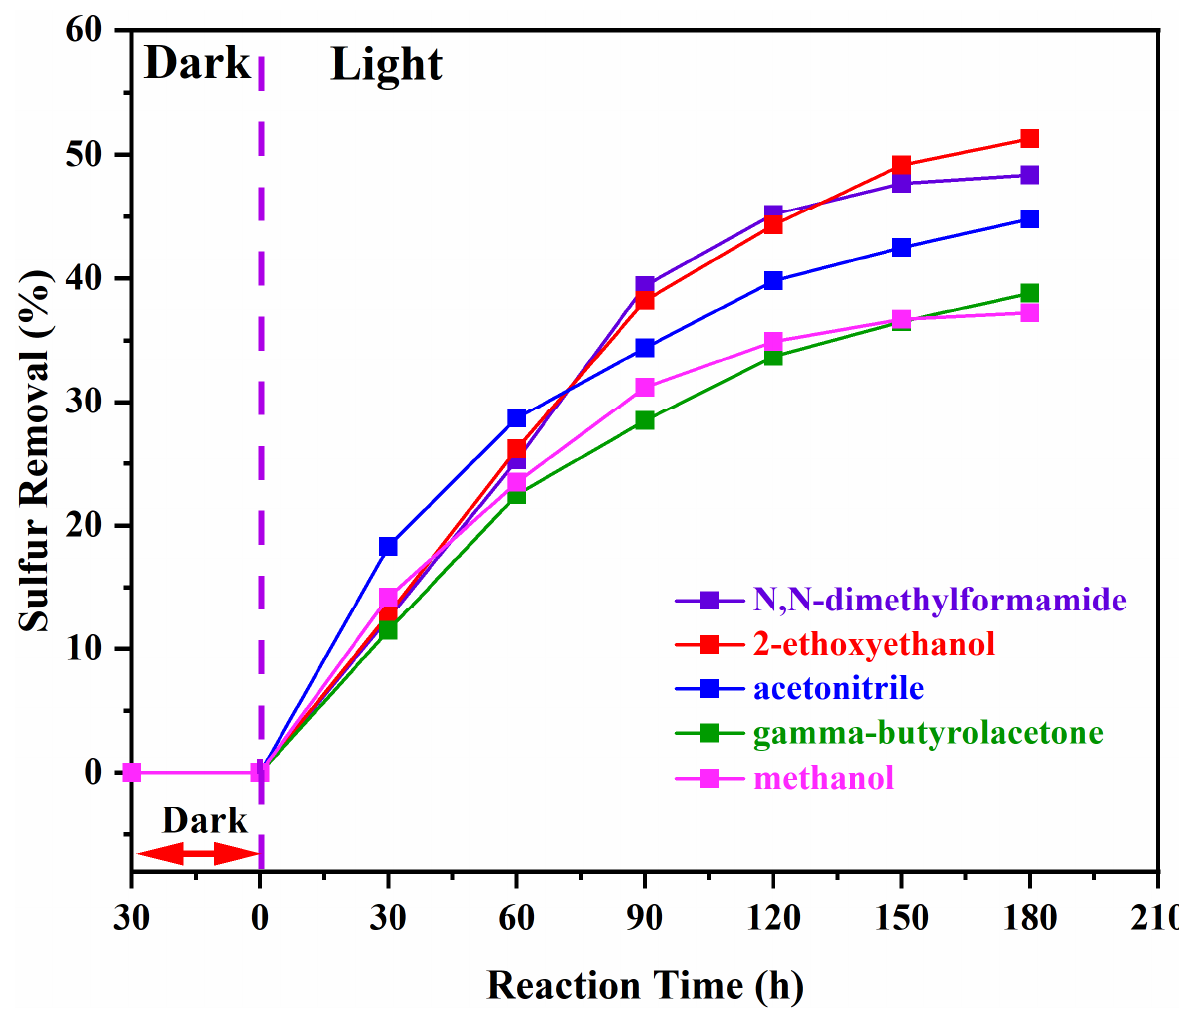
Figure 4. Effect of using (purple line) N,N-dimethylformamide, (red line) 2-ethoxyethanol, (blue line) acetonitrile, (green line) gamma-butyrolactone, and (pink line) methanol on photocatalytic desulfurization of diesel oil.